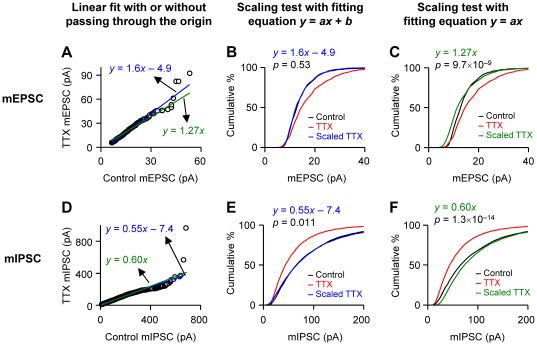
Test for multiplicative scaling of mEPSC amplitudes with a rank-order plot of amplitudes.
A. mEPSCs were recorded from CA1 pyramidal neurons in slice cultures of rat hippocampus. For induction of homeostatic plasticity of synapses, slice cultures were treated with 1–1.5 µM TTX for 3–4 days. Rank-ordered amplitudes of mEPSCs in TTX-treated cells were plotted against rank-ordered control mEPSCs. A total of 700 mEPSCs, with 100 events per cell, were collected. The straight lines are linear fits with variable (blue) or zero (green) y-intercept. B. Cumulative histograms of mEPSC amplitudes. Individual mEPSC amplitudes in TTX-treated cells were transformed with the equation y = 1.6x–4.9. The distribution of transformed values almost exactly overlaps the control distribution. The p value is from a K-S test between control and scaled TTX group. C. Cumulative histograms were obtained as in B (control and TTX plots are the same as those in B), but the TTX group was scaled with the equation y = 1.27x. The p value from a K-S test shows significant differences between control and scaled TTX groups. D. mIPSCs were obtained from control and TTX-treated slice cultures of hippocampus. The rank-order plot (D) and the cumulative histograms (E,F) were constructed in a similar manner to those in A–C. E. Cumulative histogram of mIPSC amplitudes. The amplitudes of TTX-treated mIPSCs were transformed with y = 0.55x–7.4. Again, the transformed distribution shows nearly complete overlap with the control distribution. The p value is from a K-S test between control and scaled TTX group. F. The TTX group was scaled with the equation y = 0.60x. The distributions of the control and scaled TTX groups are significantly different from each other (K-S test).